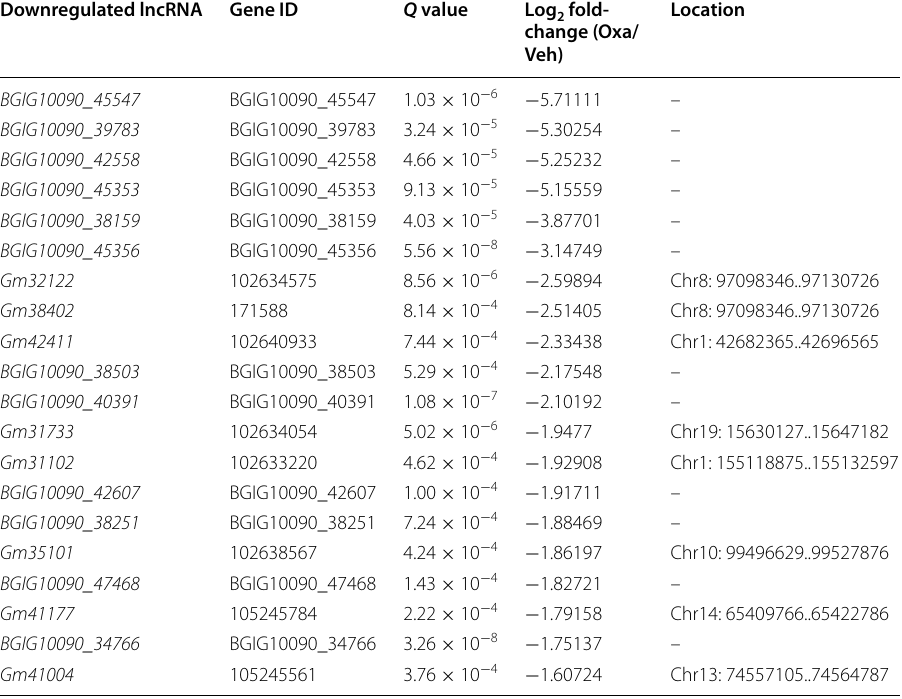
Table 5 Detailed information on the top 20 downregulated DElncRNAs Downregulated